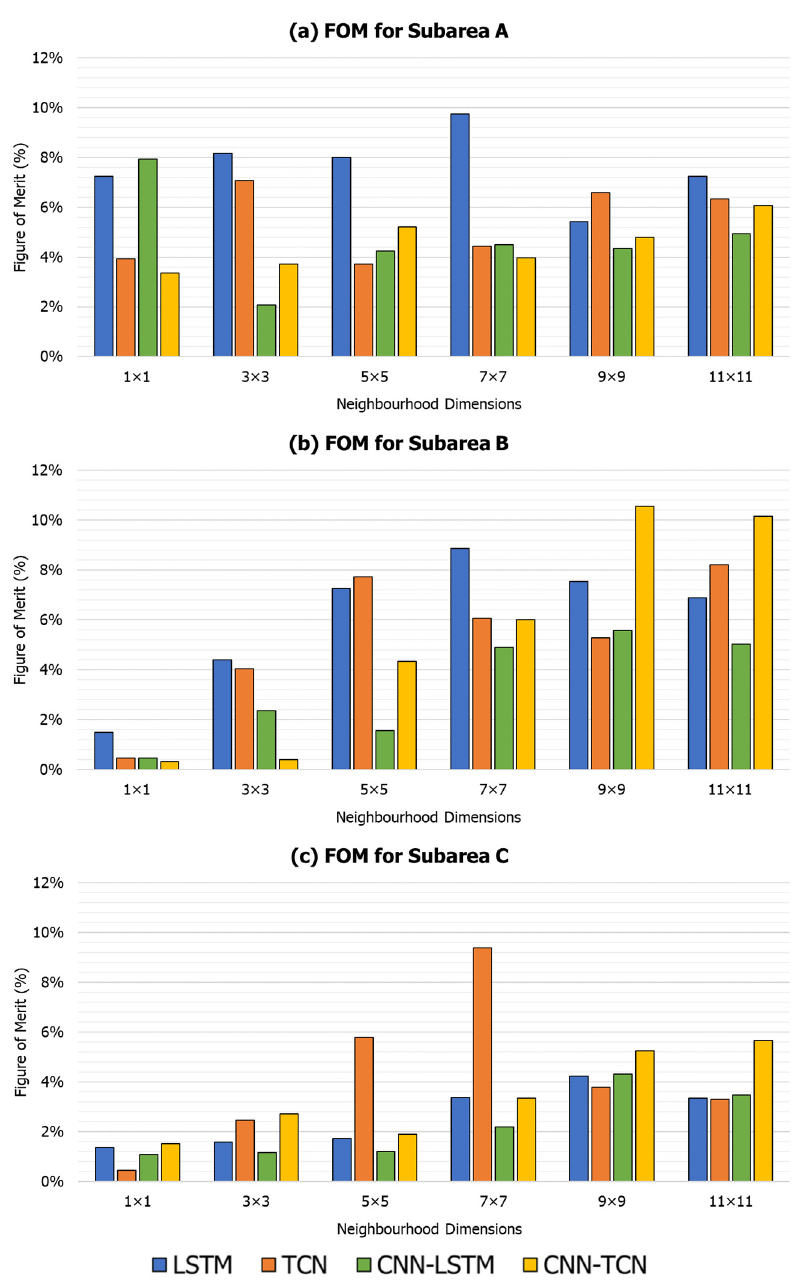
Figure 5. FOM measures computed for ( a ) Subarea A, ( b ) Subarea B, and ( c ) Subarea C in the Regional District of Bulkley-Nechako.